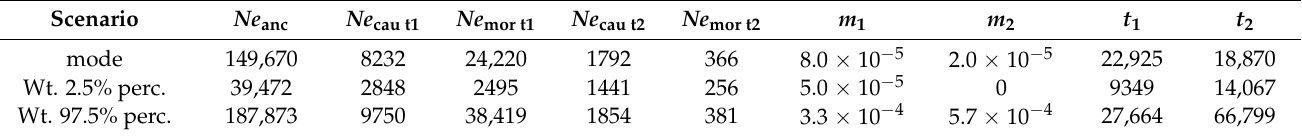
Table 3. Model parameters of the SC scenario through approximate Bayesian computation. Details model parameters of four scenarios are listed in Table